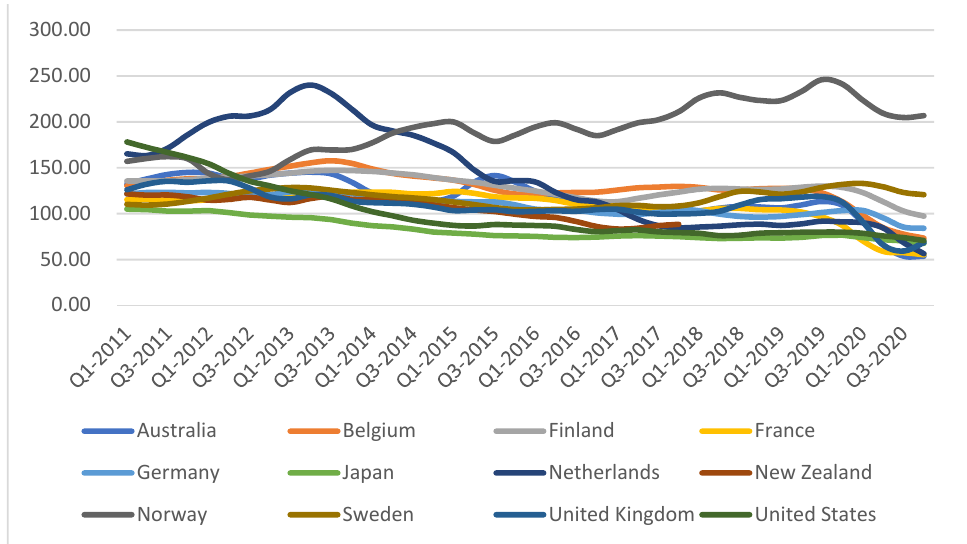
Figure 2. Declining number of bankruptcies (Quarterly, 2007 = 100). Source : OECD.Stats.